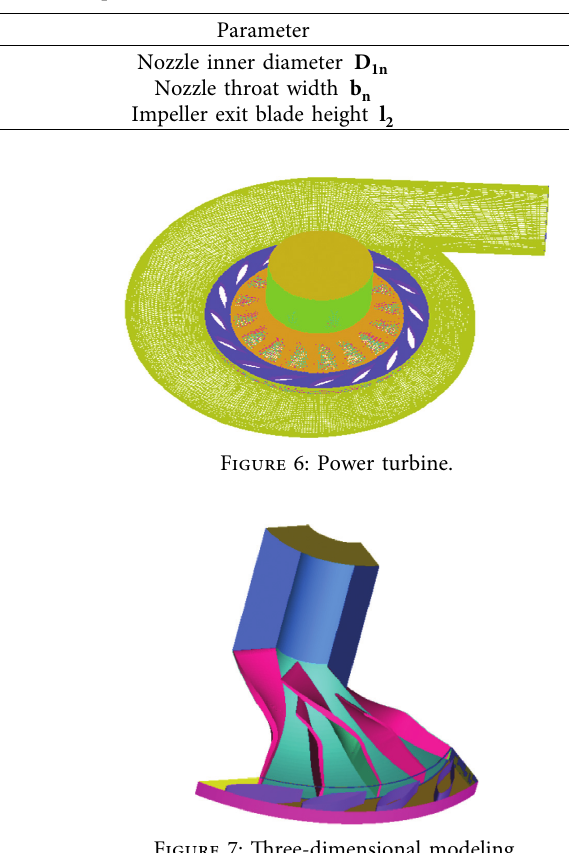
Table 1: Basic parameters of the power